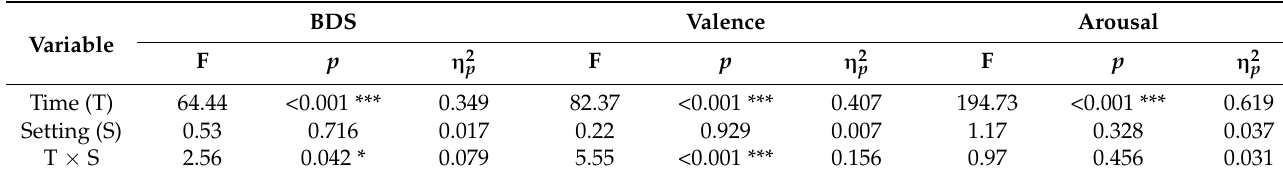
Table 1. Results of RM-ANOVA for attention function (BDS score), valence, and arousal.